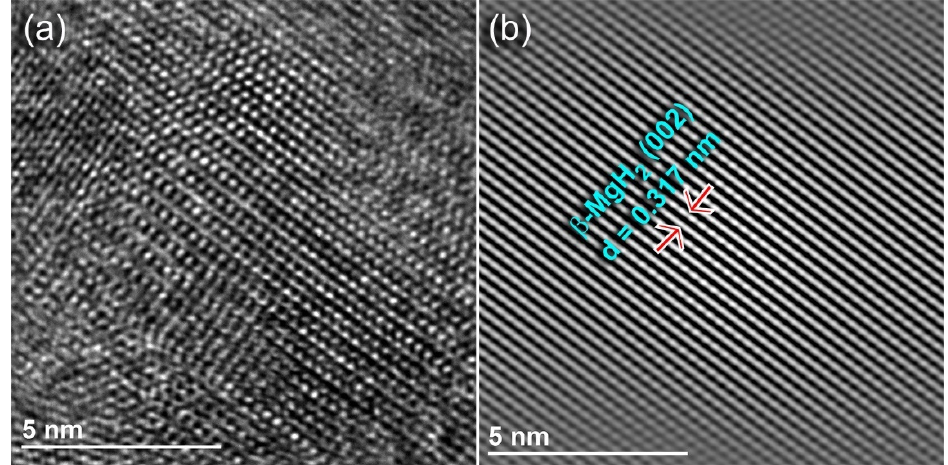
Figure 3. ( a ) Field emission high-resolution transmission electron microscope (FE-HRTEM) image of MgH 2 powders obtained after 18 h of RBM. The filtered-atomic-scale TEM image of the fringe image in ( a ) is present in ( b ).